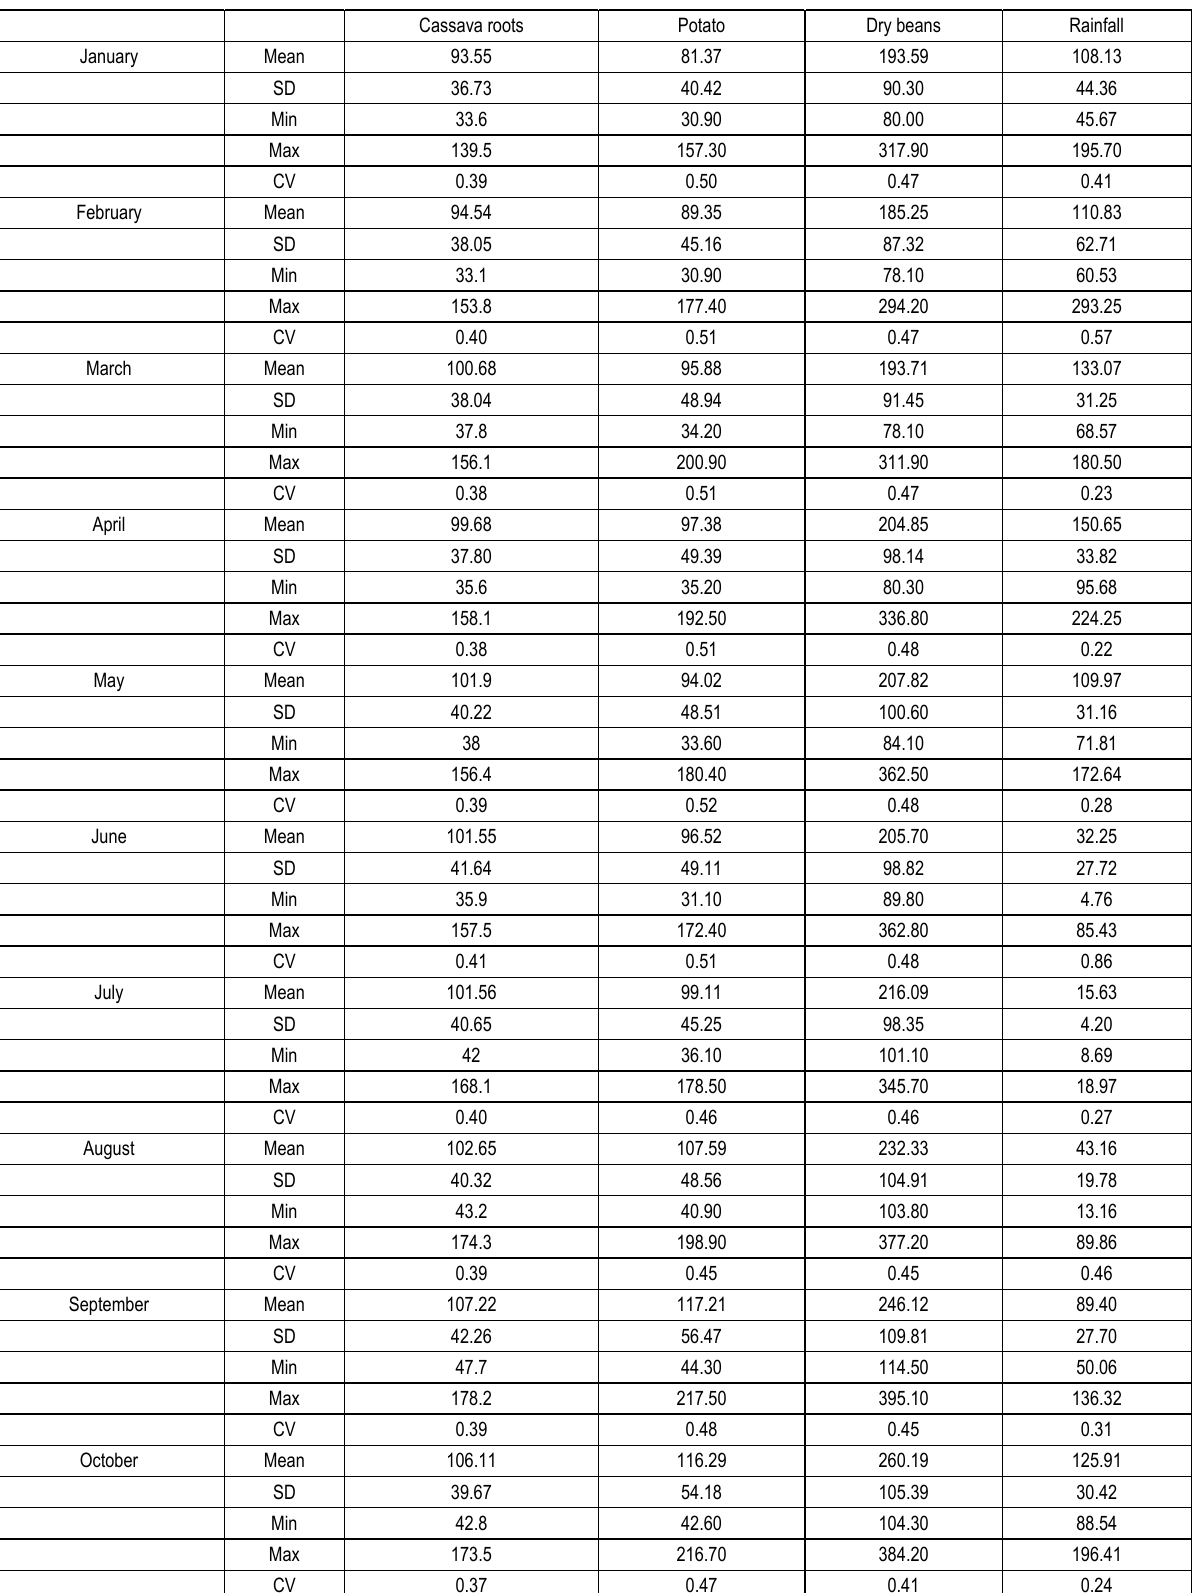
Table 1. Descriptive statistics on key variables of interest in the study (real prices are expressed in Rwandan Francs; rainfall is in millimetres) Cassava roots Potato Dry beans